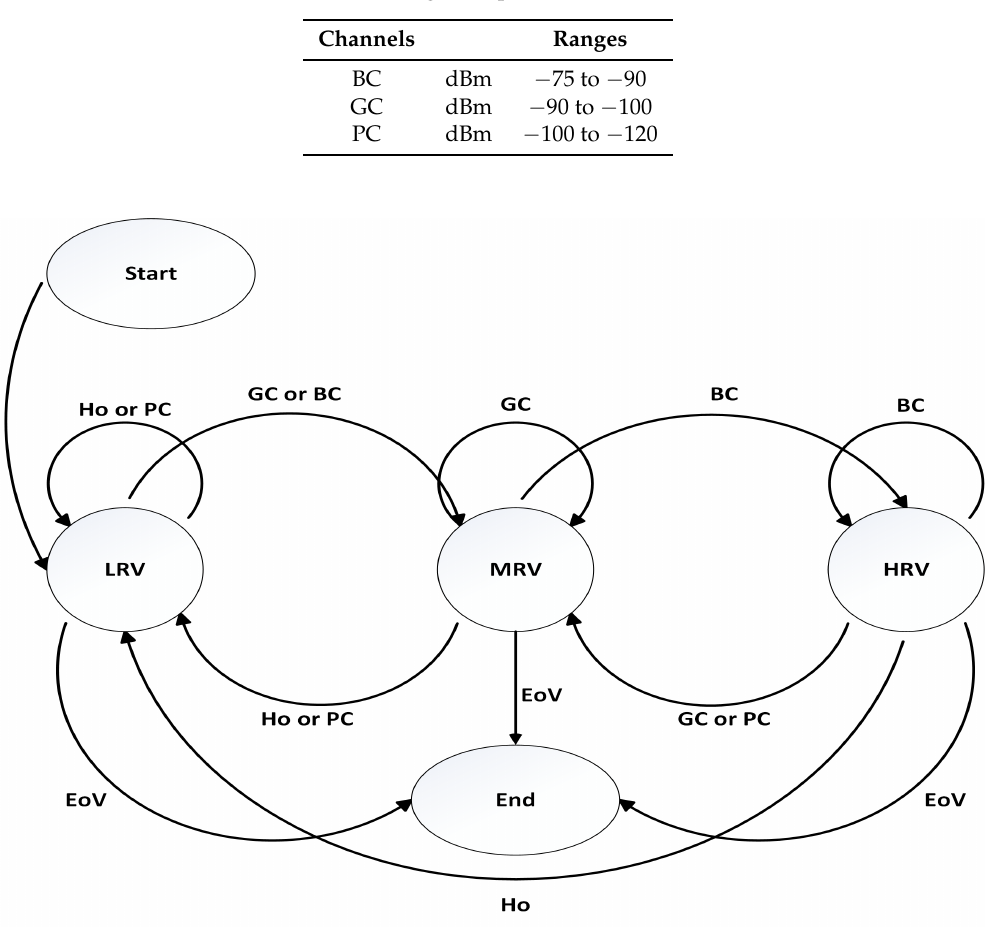
Table 2. Ranges of specified channels.